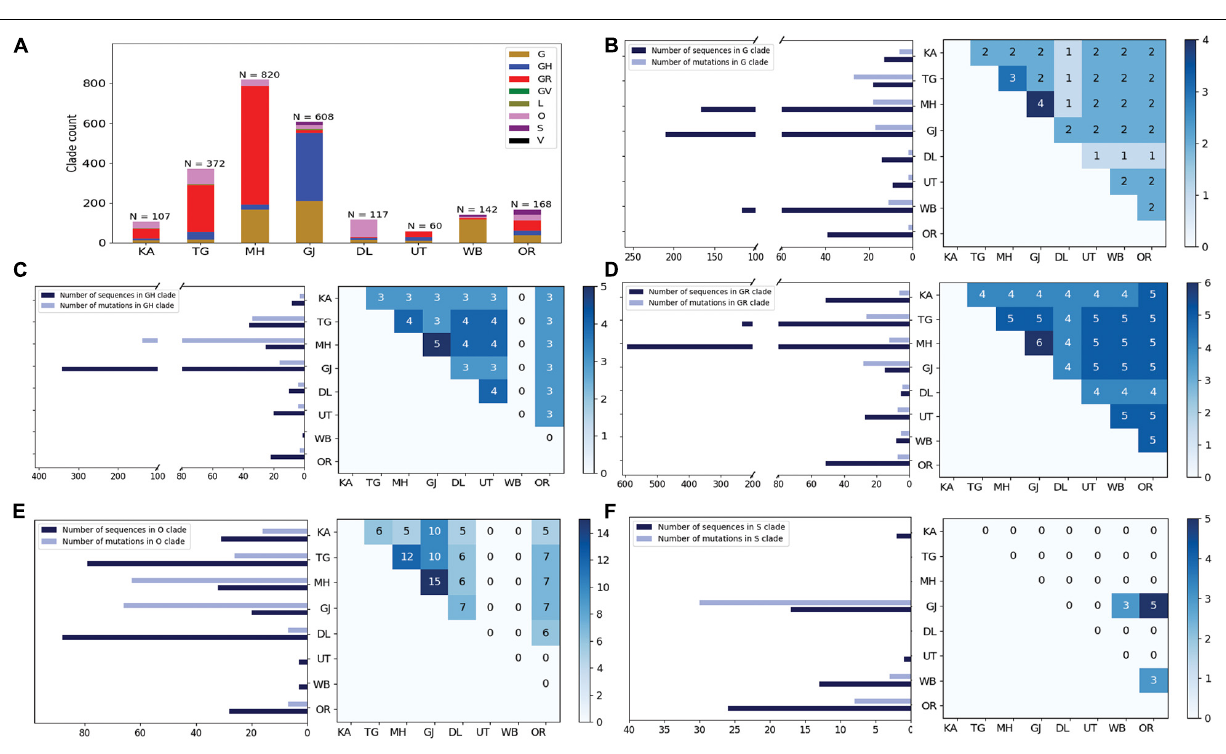
FIGURE 2 | Distribution of GISAID clades within Indian states and union territories and comparison of frequent mutations across them during Term2 (April 2020–July 2020). (A) The distribution of GISAID clades in seven Indian states and one union territory (UT) that deposited more than 50 SARS-CoV-2 sequences during April 2020–July 2020. (B–F) The number of sequences and frequent mutations of the seven states and one UT and the number of common mutations among them for G, GR, GH, O, and S clades, respectively. KA, Karnataka; TG, Telangana; MH, Maharashtra; GJ, Gujarat; DL, Delhi; UT, Uttarakhand; WB, West Bengal; OR,